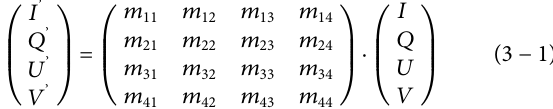
Frontiers in Physics |